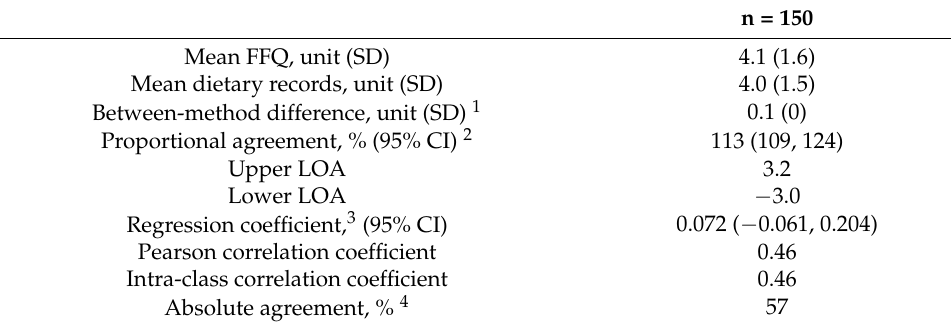
Table 6. Correlation coefficients and between-method agreement of the Mediterranean diet adher- ence